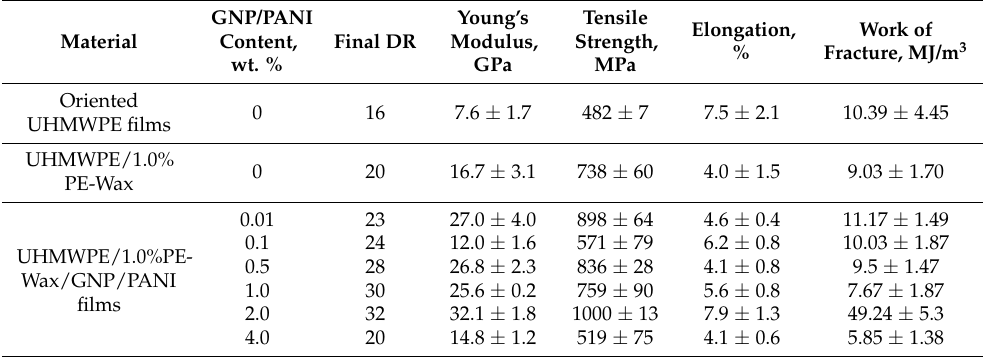
Table 4. Mechanical tensile properties of the UHMWPE/PE-wax/GNP/PANI films with different GNP/PANI content obtained by second thermal orientation regime ( ± the standard